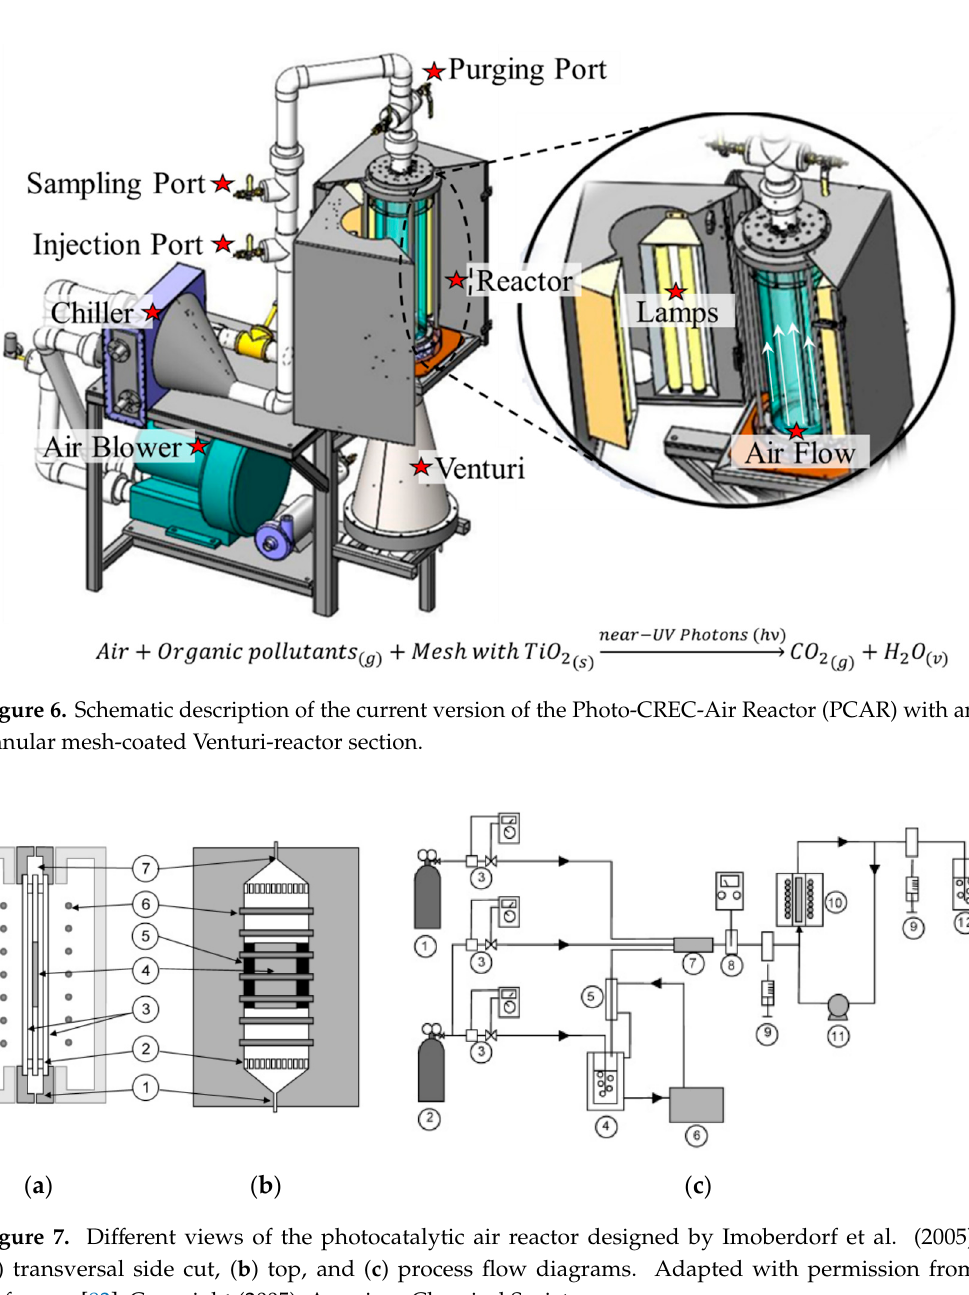
Figure 8. Experimental air treatment setup proposed by Debono et al. (2011). Reprinted from References [77,78], Copyright (2011), with permission from Elsevier. Dong et al. (2014) customized an experimental 4.5 L continuous flow photocatalytic reactor, with a “horizontal” TiO 2 -coated ceramic foam, placed in the same direction as the gas flow. This reactor was specifically designed for operation at ambient temperature under controlled relative humidity and using two (2) domestic energy-saving lamps (refer Figure 9a). Efficiency was demonstrated by eliminating 600 ppb of NO in air at room temperature and close to atmospheric pressure, achieving a 77% NO removal in 30 min as NO 2 and H 2 O [80]. Furthermore, Zhong et al. (2013) used a different open-loop photocatalytic reactor design, made of four “parallel” aluminum ducts, with commercial filters coated with TiO 2 , situated transversally to the direction of the airflow. This research group studied the oxidation of a variety of VOCs (refer to Figure 9b) by using (i) a vacuum ultraviolet (VUV) lamp and germicidal (UVC) irradiation amounting to 18.4 W per lamp, (ii) a gas mixer feeder, (iii) two commercially available filters for TiO 2 coating, with these being fabricated of fiberglass and carbon cloth fiber, (iv) airflow rates of 255 m 3 /h, generated by a radial fan (mounted at the end of each duct) with a speed regulator, and (v) controlled